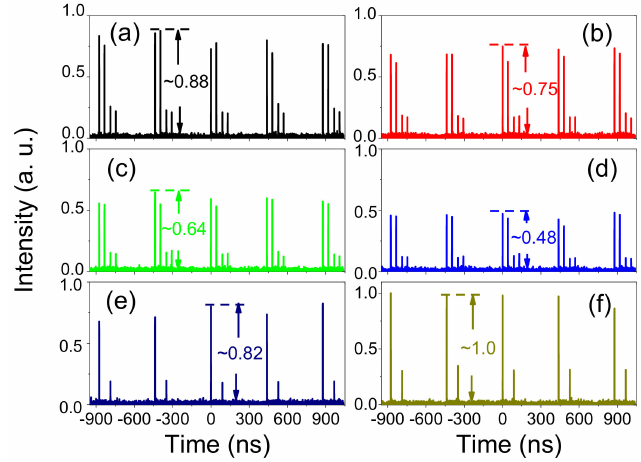
Figure 5. Output pulse evolving process when the cavity parameters changes; ( a ) the twin-pulse DSs with a pump power of 560 mW; ( b ) the twin-pulse DSs with a pump power of 520 mW; ( c ) the twin-pulse DSs with a pump power of 474 mW; ( d ) the twin-pulse DSs with a pump power of 430 mW; ( e ) the single-pulse DS with a pump power of 430 mW; ( f ) the single-pulse DS with polarization state